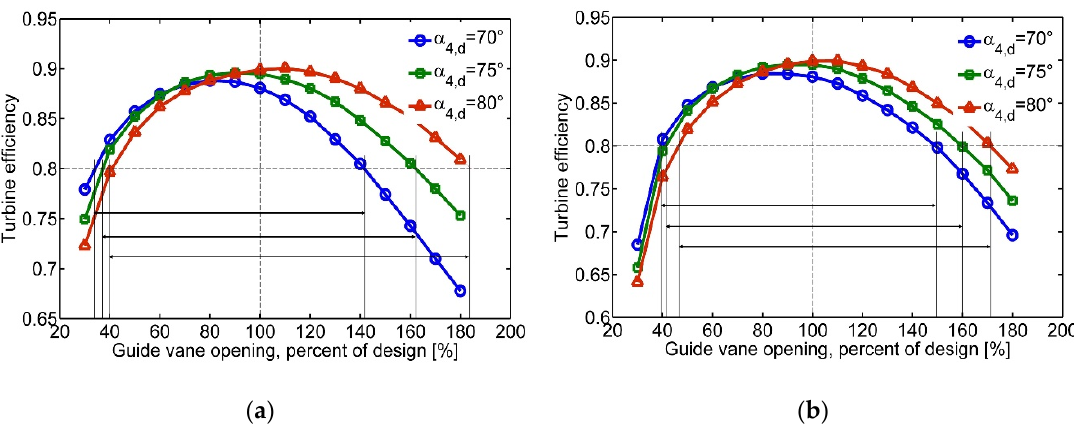
Figure 11. Turbine performances when the guide vane opening changes and: ( a ) the pressure ratio is constant; ( b ) the pressure ratio changes inversely to the guide vane opening.